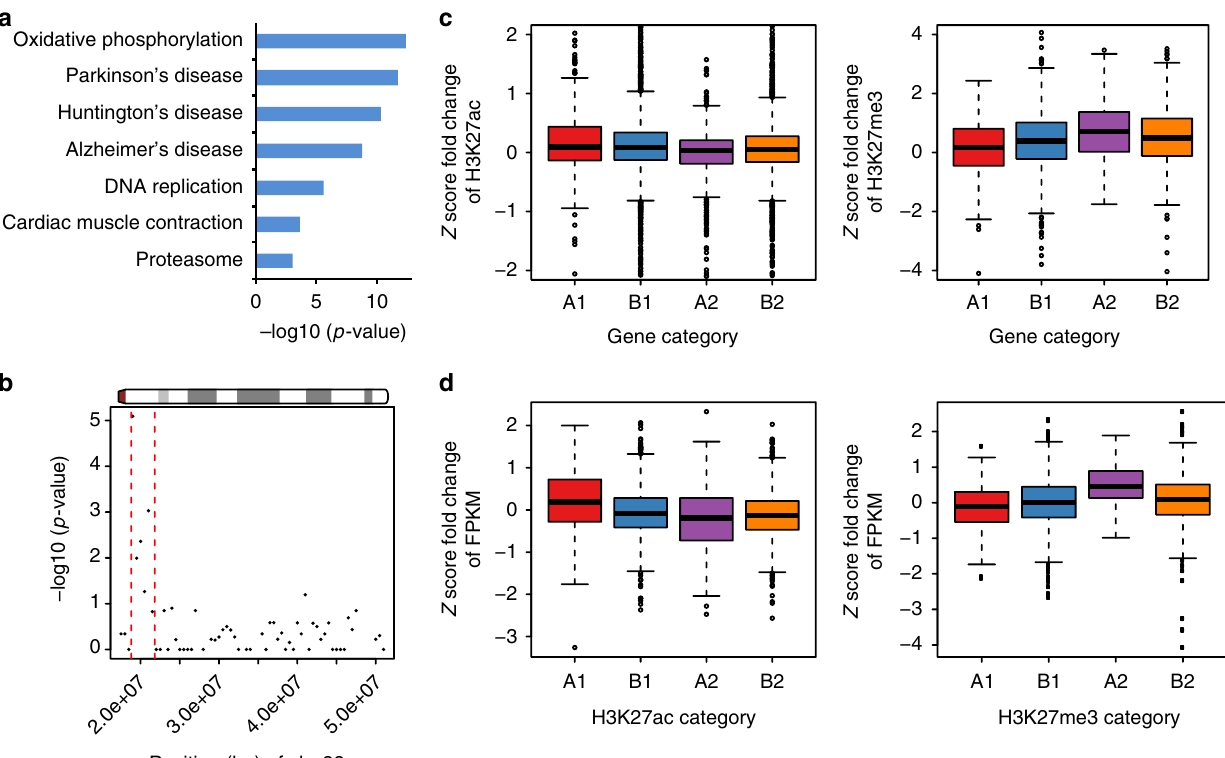
Fig. 7 Differential expression analysis and correlation between gene expression and epigenetic pro fi les. a KEGG pathway analysis for genes differentially expressed between 22q11.2del ( n = 5) and control ( n = 9) cell lines. Shown are pathways with modi fi ed Fisher ’ s exact test p value < 9.05e − 04. b Enrichment analysis for chromosome 22q for differentially expressed genes. Red dashed lines mark the boundaries of 22q11.2del region. c Differentially expressed genes correlated with different H3K27ac and H3K27me3 signal strengths in 22q11.2del versus control cell lines. A1 represents genes signi fi cantly upregulated in 22q11.2del cell lines while B1 represents non-signi fi cantly upregulated genes; A2 represents genes signi fi cantly downregulated in 22q11.2del cell lines while B2 represents non-signi fi cantly downregulated genes. The y axis shows the Z -score transformed fold change of H3K27ac signals (left) or H3K27me3 signals (right) between 22q11.2del ( n = 5) and control ( n = 4) cell lines. d Differential H3K27ac and H3K27me3 signal strengths exhibited correlation with differential gene expression between 22q11.2del and control cell lines. A1 represents genes whose TSSs were signi fi cantly more marked by H3K27ac (left) or by H3K27me3 (right) in 22q11.2del cell lines. B1 represents genes with TSSs non-signi fi cantly more marked by H3K27ac (left) or by H3K27me3 (right). A2 represents genes whose TSSs were signi fi cantly less marked by H3K27ac (left) or by H3K27me3 (right) in 22q11.2del cell lines. B2 represents genes with TSSs non-signi fi cantly less marked by H3K27ac (left) or by H3K27me3 (right). The y axis shows the Z -score transformed fold change of genes ’ FPKM in 22q11.2del ( n = 5) versus control ( n = 9) cell lines. In c , d , box represents quartiles, centre line denotes 50th percentile, and whiskers extend to the most extreme data points within 1.5 times of the interquartile